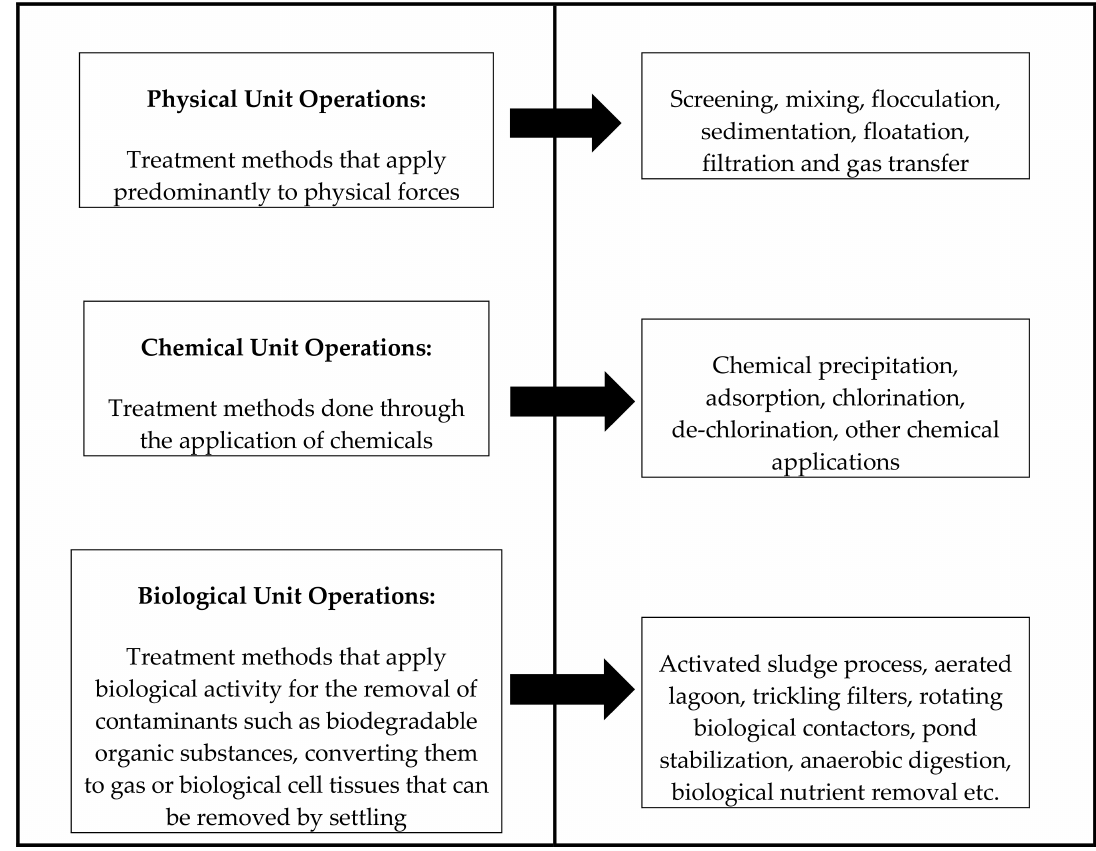
Figure 1. Summary of wastewater treatment unit operations. Source: